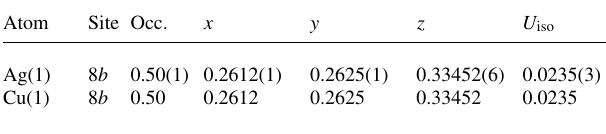
Table 2. Atomic coordinates and displacement parameters (in Å 2 )